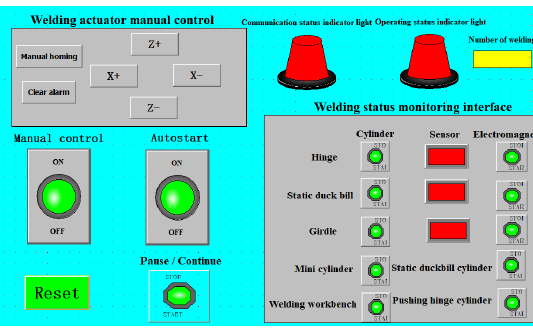
Figure 18. Factory test of cotton seeder duckbill welding robot. ( a ) Welding test site; ( b ) welding test in progress.